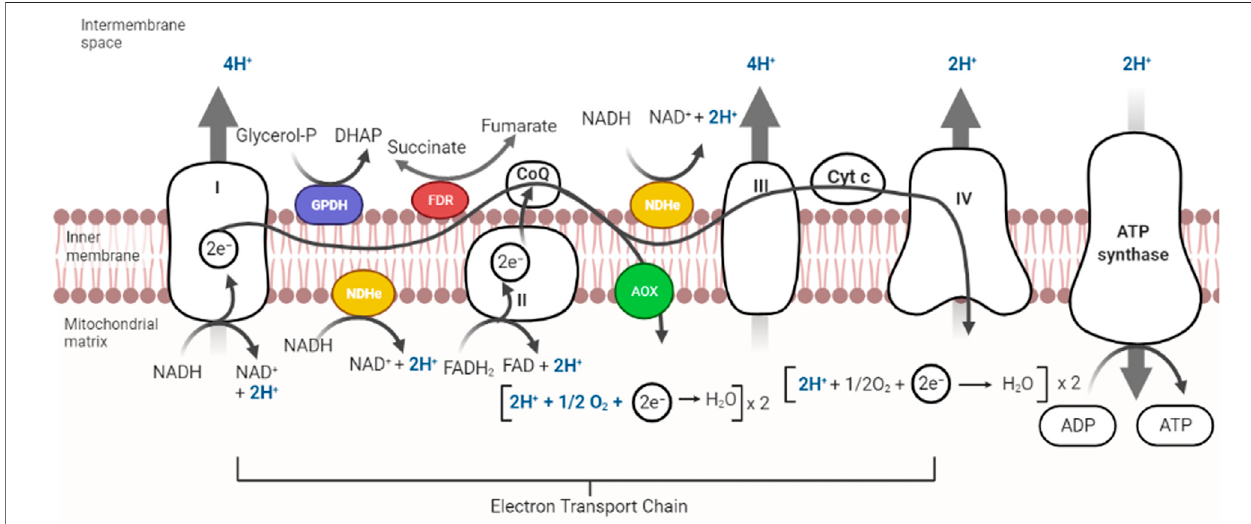
FIGURE 2 | Components in mitochondrial respiratory chains. Most mitochondrial RCs are constituted by the classic complexes I, II, III, and IV. In addition, some RCscontainalternativeredoxenzymesdonatingelectronstothequinonepoolsuchasalternative NADHdehydrogenase(in yellow), Glycerol-P-dehydrogenase (purple) or fumarate reductase (red). An alternative oxidase (AOX) oxidizes quinol reducing O 2 . Branched RCs skip proton pumps, decreasing proton pumping stoichiometry. Complex V uses proton gradients to produce ATP.